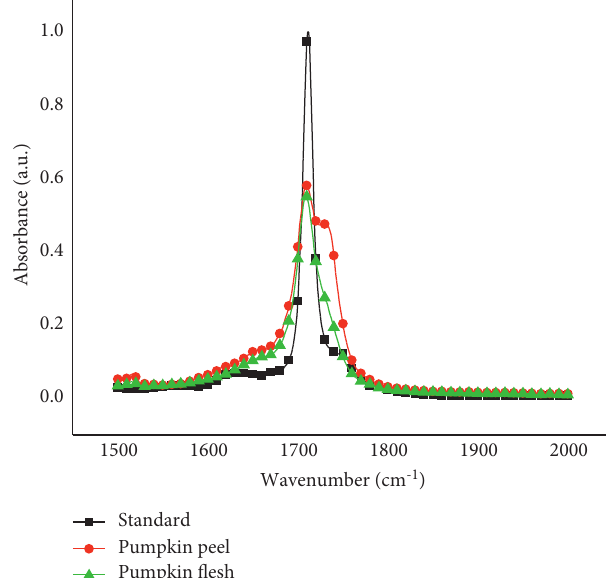
Figure 9: FTIR spectra of standard β -carotene and β -carotene from pumpkin flesh and peel in acetonitrile